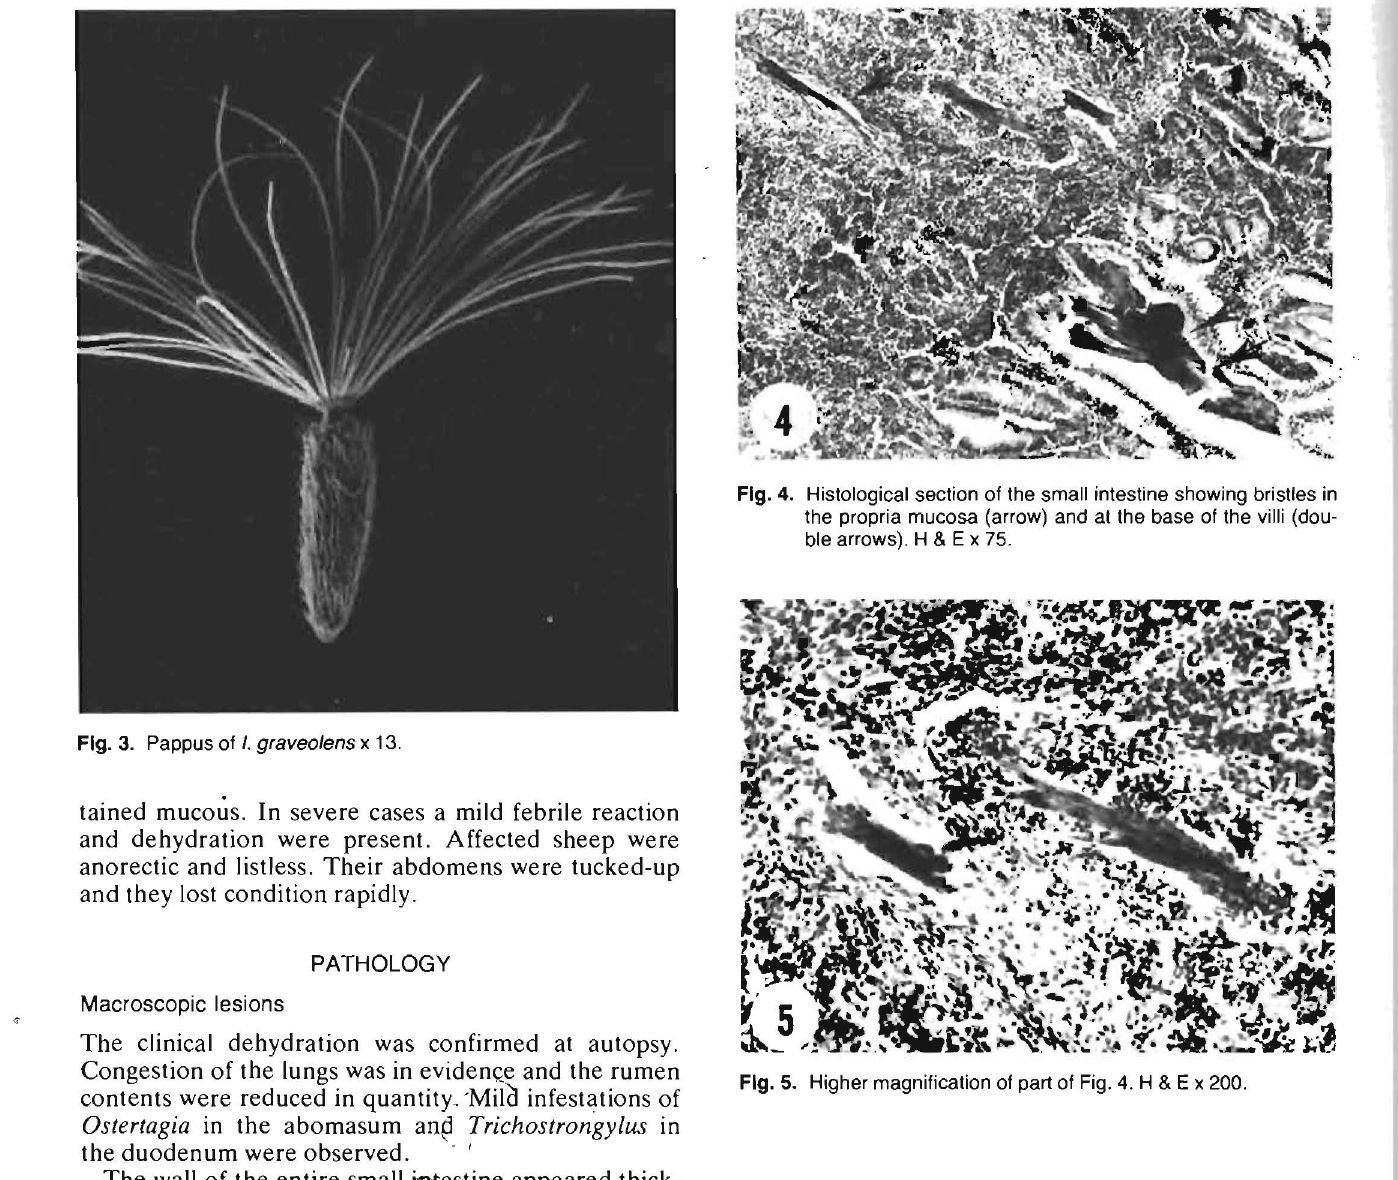
Fig. 4. Histological section of the small intestine showing bristles in the propria mucosa (arrow) and at the base of the villi (dou ble arrows). H & Ex 75.